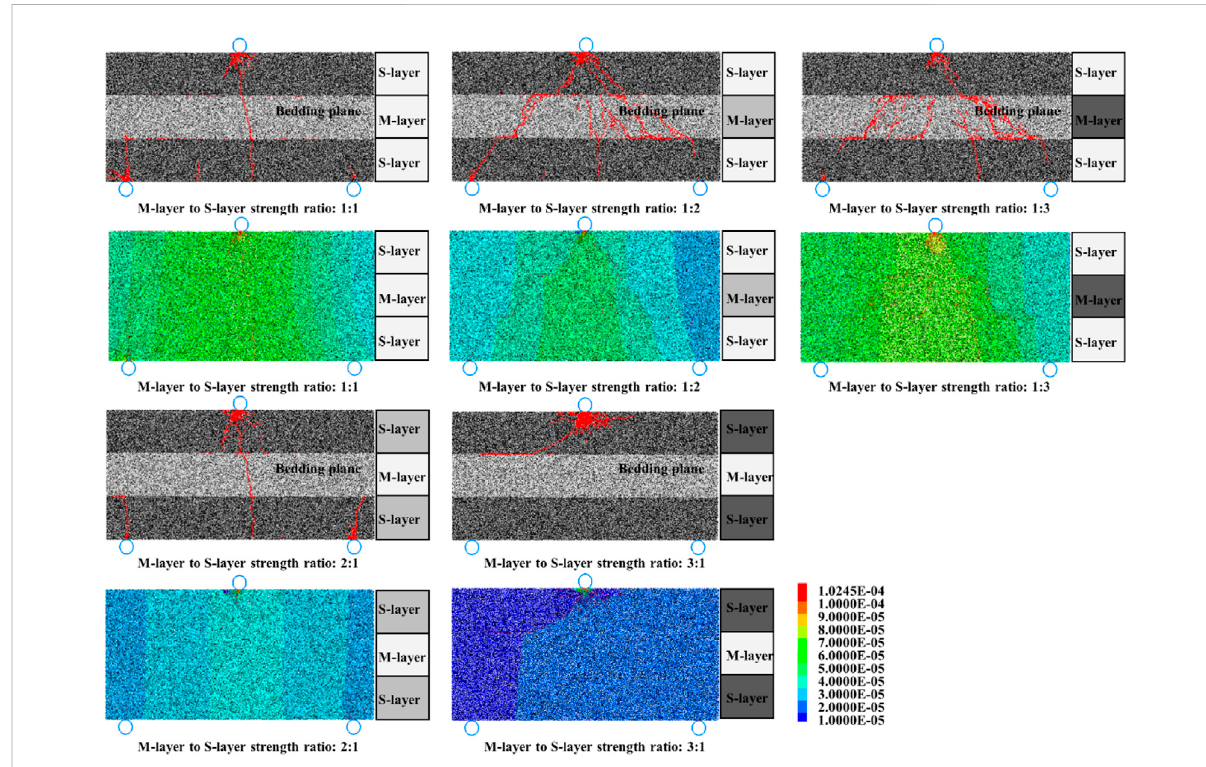
FIGURE 12 Crack propagation paths and surface displacement clouds for different materials strength